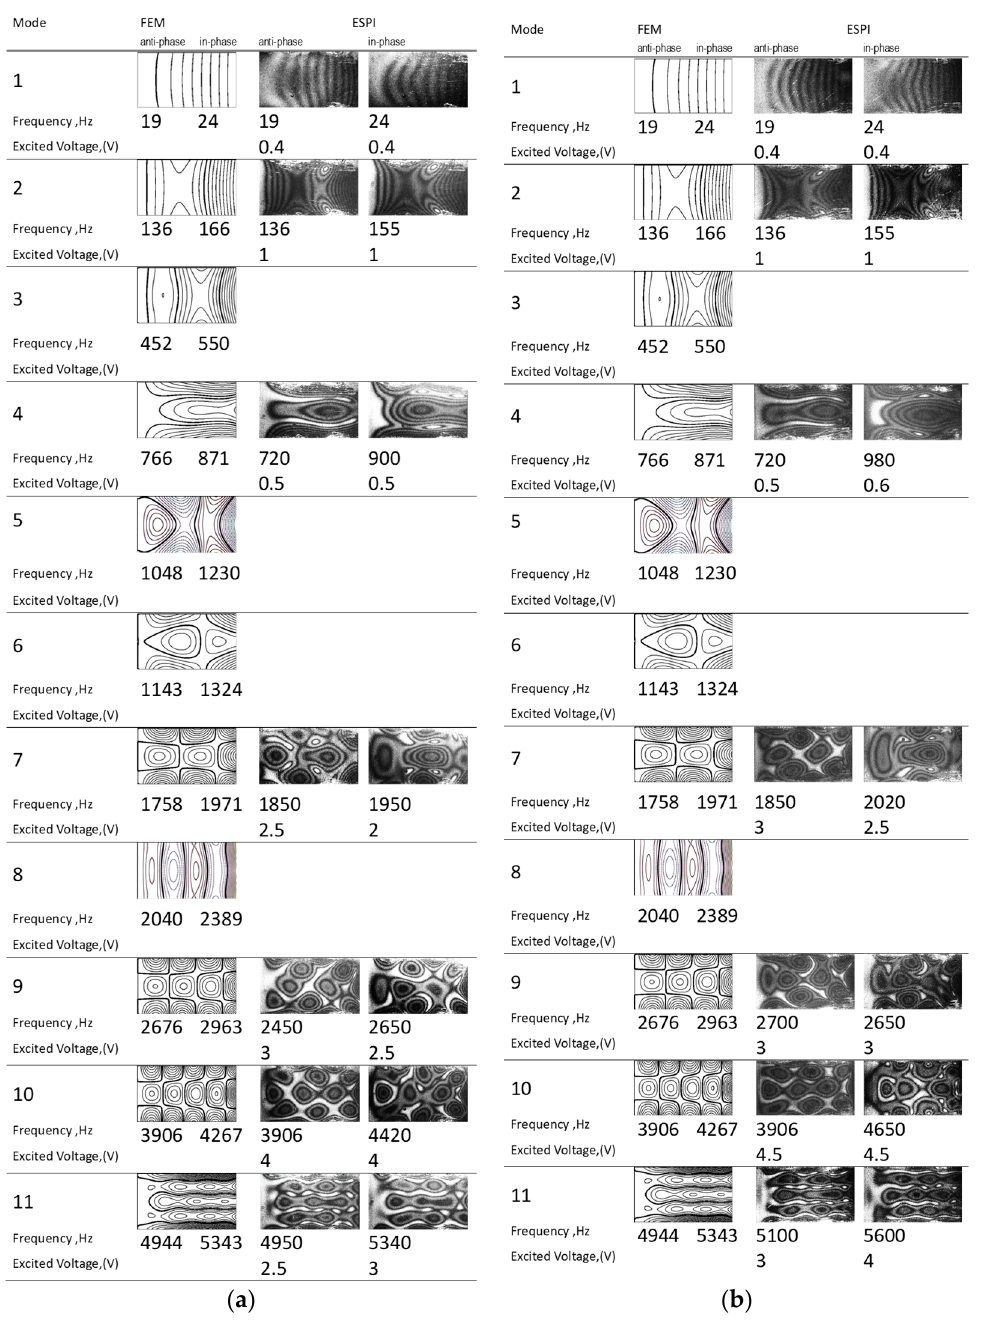
Figure 10. AF-ESPI and FEM results obtained from pumping element coupled with glycerin on the ( a ) upper and ( b ) lower piezoelectric plates.